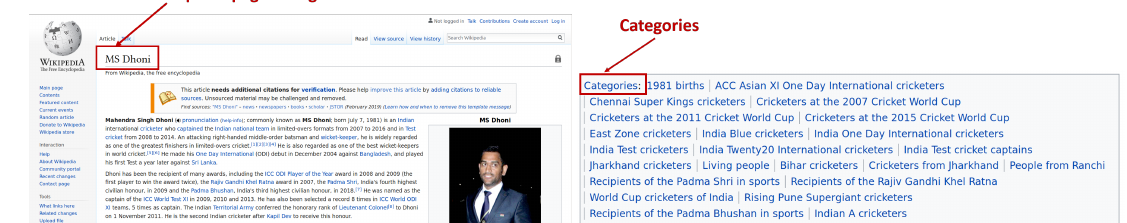
Figure 3. Title and categories of a Wikipedia page in English.